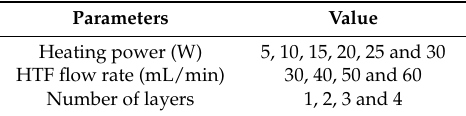
Table 3. The volume and mass flow rates of water.